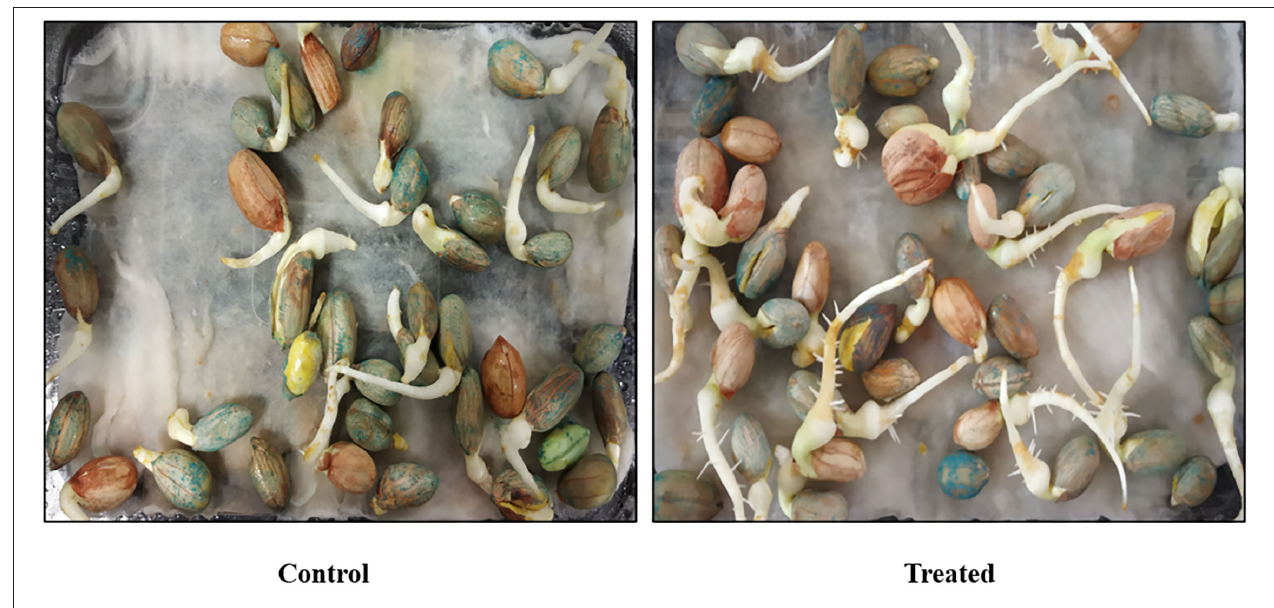
FIGURE 5 | Seed germination by Bacillus sp. PG-8.